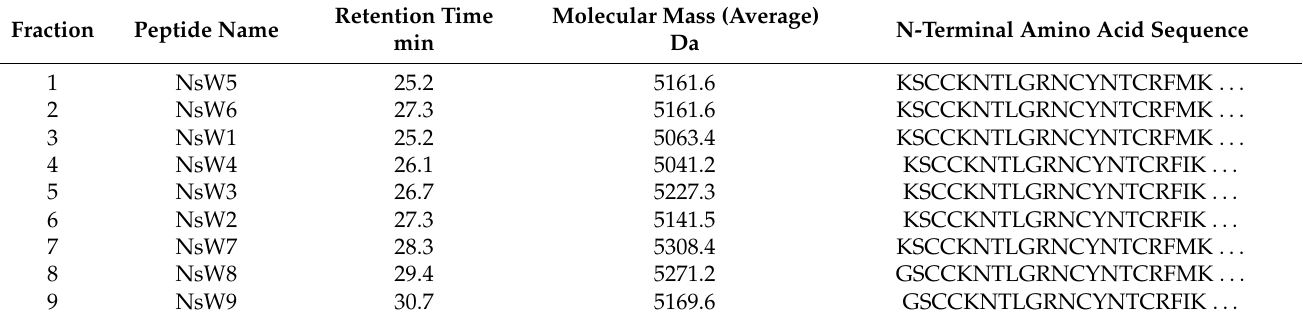
Table 1. Initial structural analysis of the individual fractions collected after analytical reversed-phase